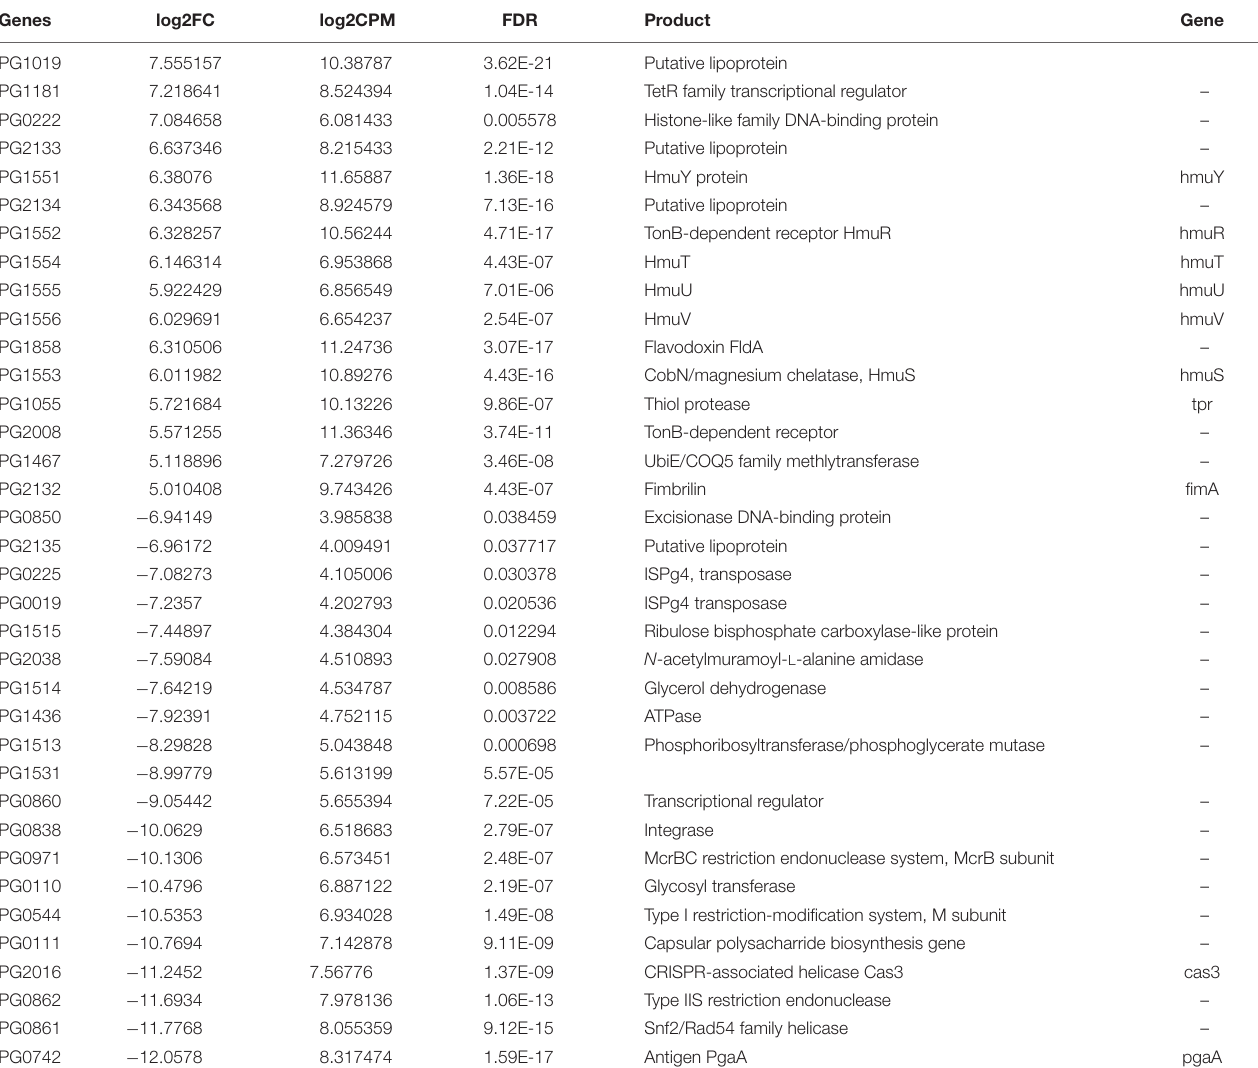
TABLE 1 | Differentially expressed genes (|log2FC| ≥ 5) between periodontitis and laboratory culture in Porphyromonas gingivalis. Genes log2FC log2CPM FDR